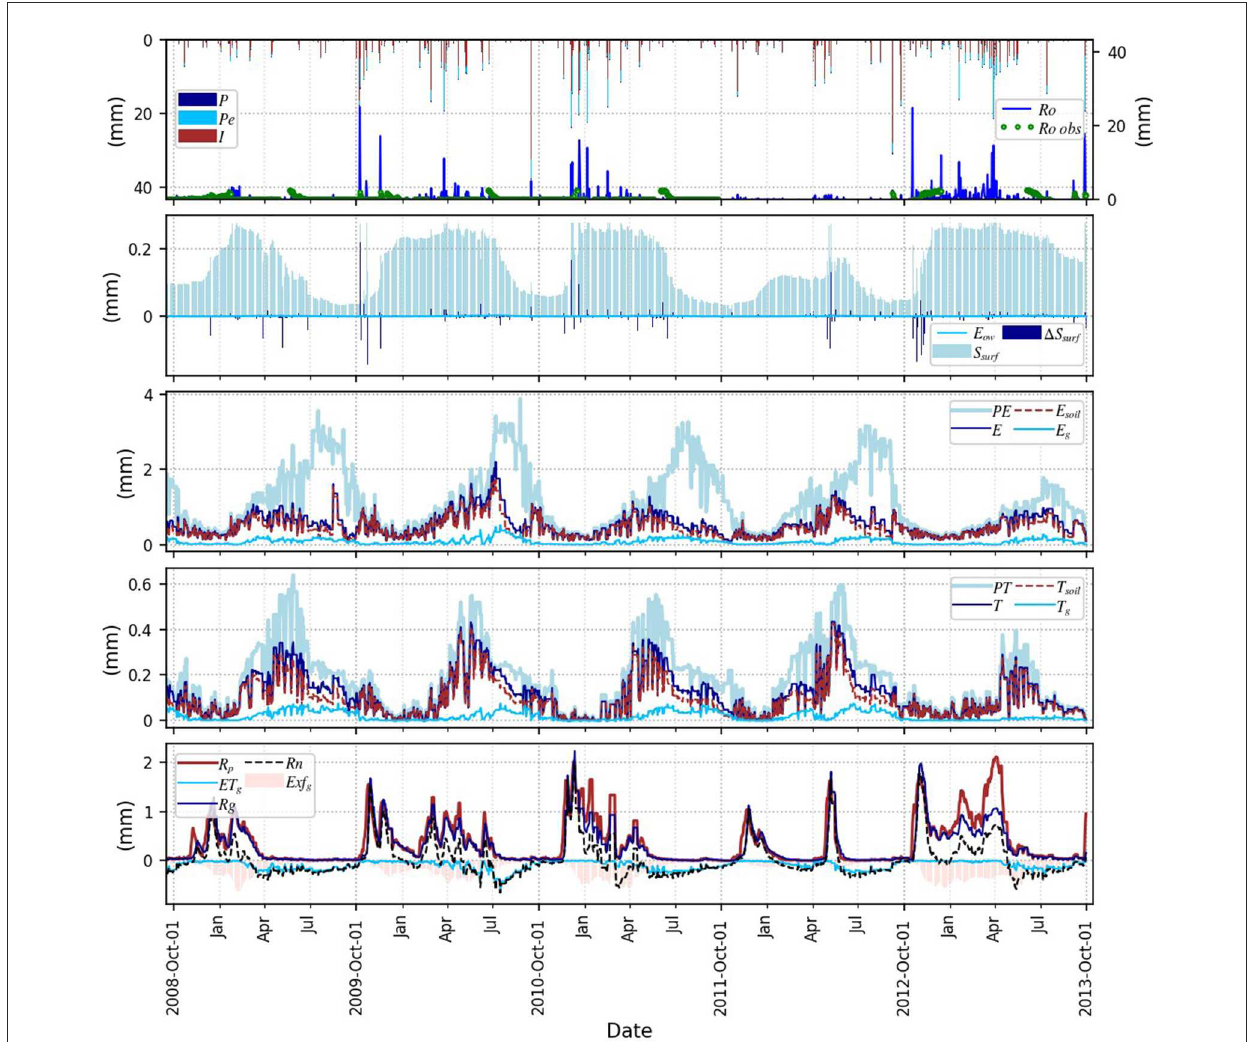
FIGURE7 Time series of surface and subsurface water fluxes averaged at the La Mata catchment scale. PE , potential evaporation; PT , potential transpiration. Ro obs , runoff measured at the Sardón catchment outlet and corrected using the area ratio (see Section 3.7). See Figure 2 for other explanations. Soil moisture and hydraulic heads time series are available in Supplementary Figure